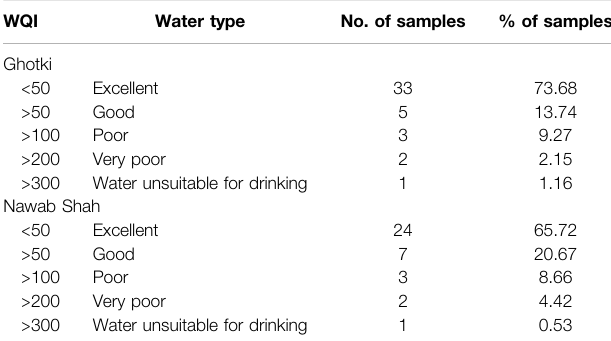
TABLE 3 | Classi fi cation of groundwater quality according to the Water Quality Index (WQI). WQI